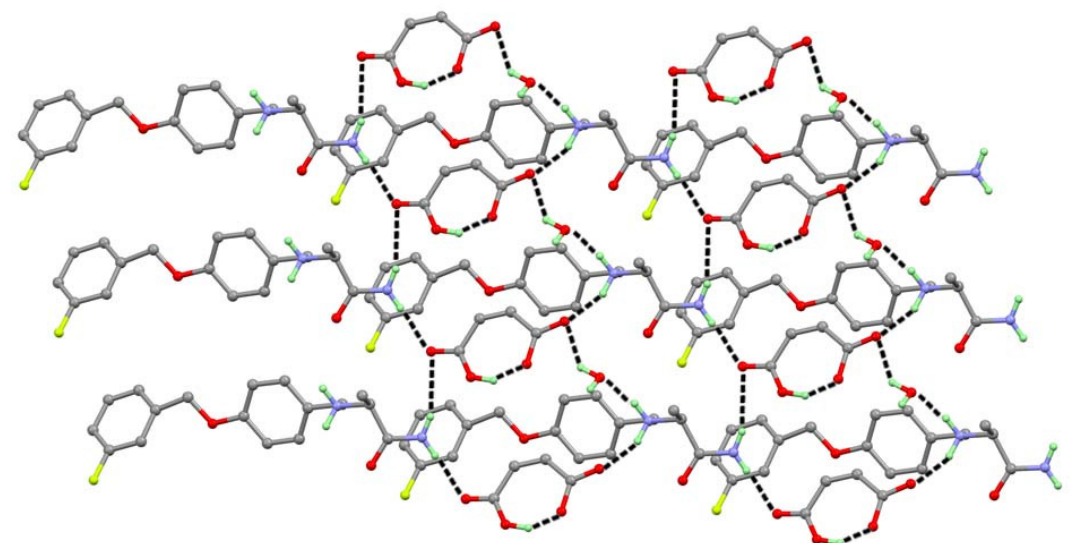
(20) two-dimensional 7